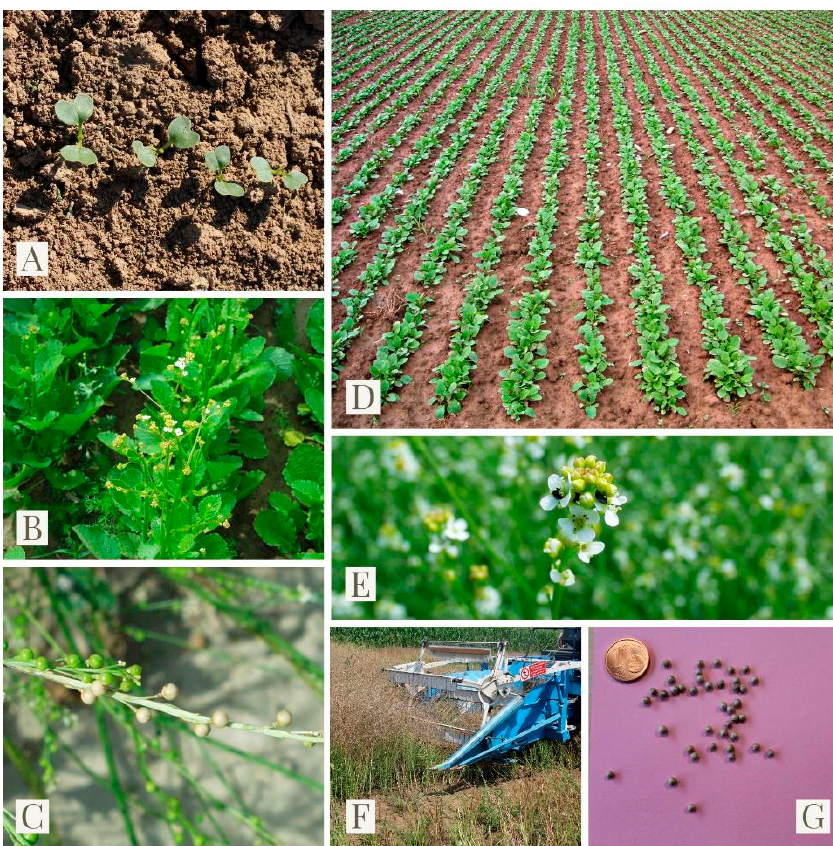
Figure 1. Details of crambe plants: ( A ) cotyledons at emergence stage; ( B ) crambe plants at bolting stage; ( C ) crambe siliques (hulls) during seed filling stage; ( D ) crambe at rosette stage; ( E ) crambe flowers; ( F ) crambe stand at harvest; ( G ) crambe seeds. (Photos by F. Zanetti).